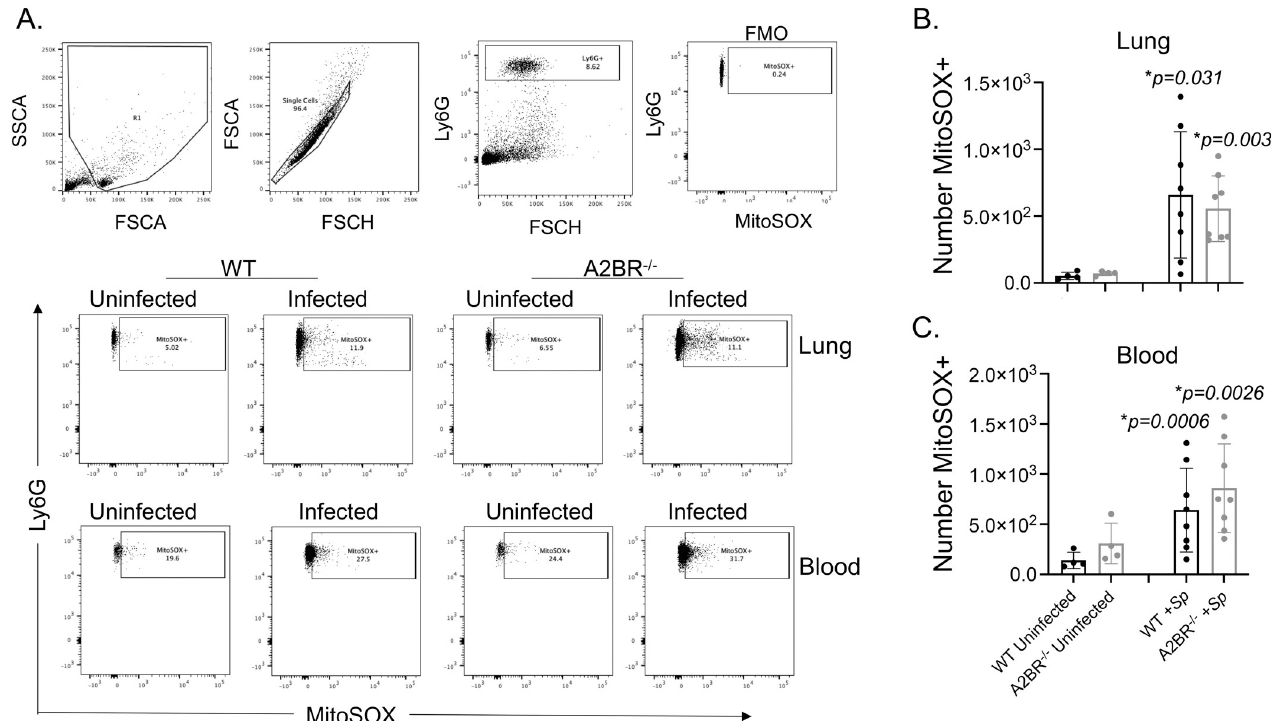
Fig 8. Mitochondrial ROS are produced by PMNs following pulmonary challenge. A2BR -/- (light grey) mice were infected with S . pneumoniae TIGR4 intra- tracheally. At 18 hours following challenge, the number of mitochondrial ROS producing PMNs (Ly6G+) in the lungs (B) and circulation (C) were determined by flow cytometry using MitoSOX (see Materials and Methods). (A) Gating strategy is shown including controls (FMO indicates absence of MitSOX dye only). (B-C) Data are pooled from two separate experiments and each dot represents an individual mouse. (C) � indicates significant differences from uninfected controls for each mouse strain and # indicates significant differences between indicated groups as determined by one-way ANOVA followed by Tukey’s multiple comparisons test.